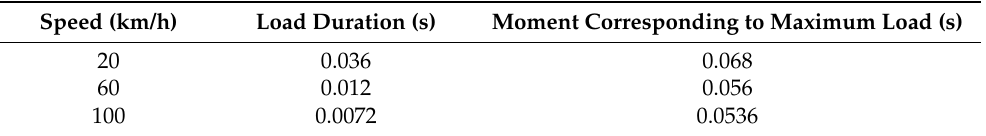
Table 2. Vehicle speed and load duration.